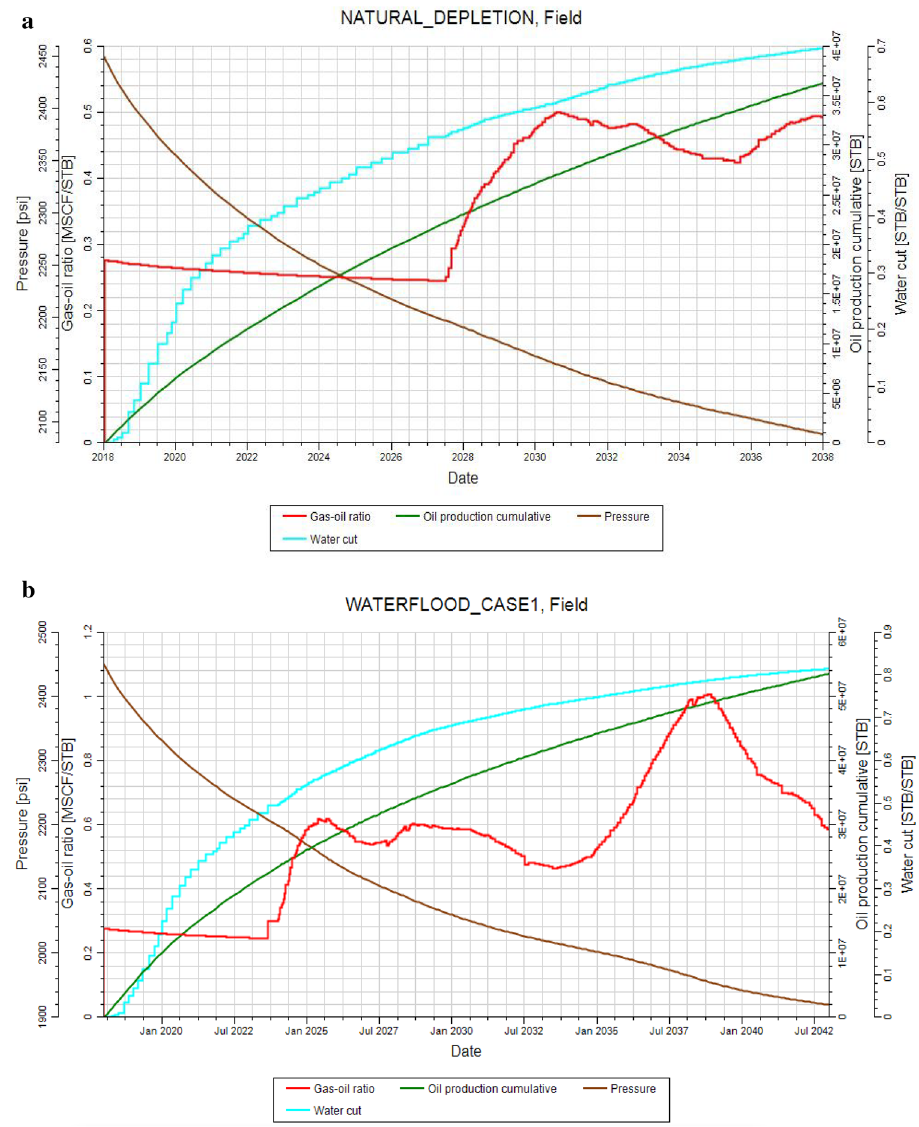
Fig. 11 a Reservoir production performance for